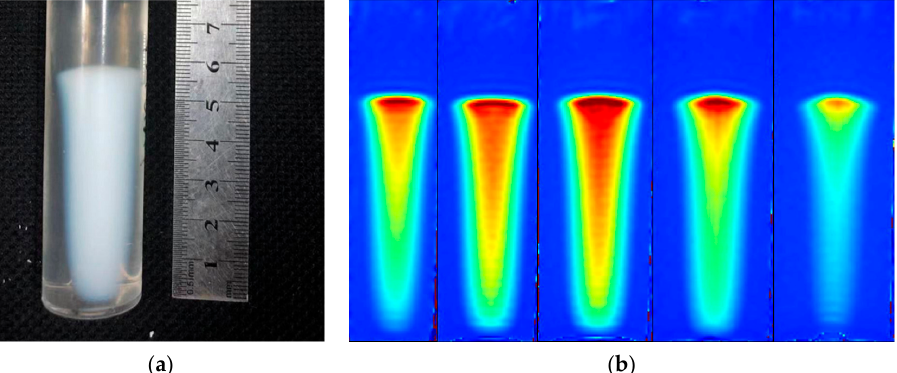
Figure 3. ( a ) Irradiated polymer gel dosimeter and ( b ) five R 2 maps of the gel at different planes (100.2 MeV).